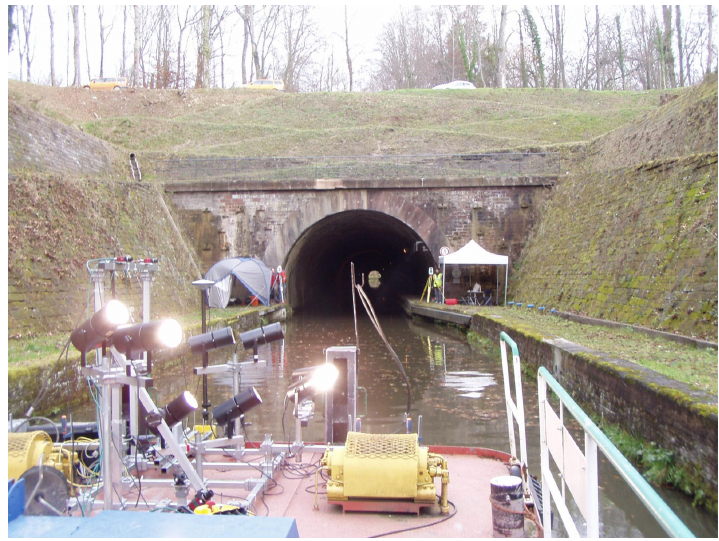
Figure 1. Modular on-board mobile image recording system at the experimental site.